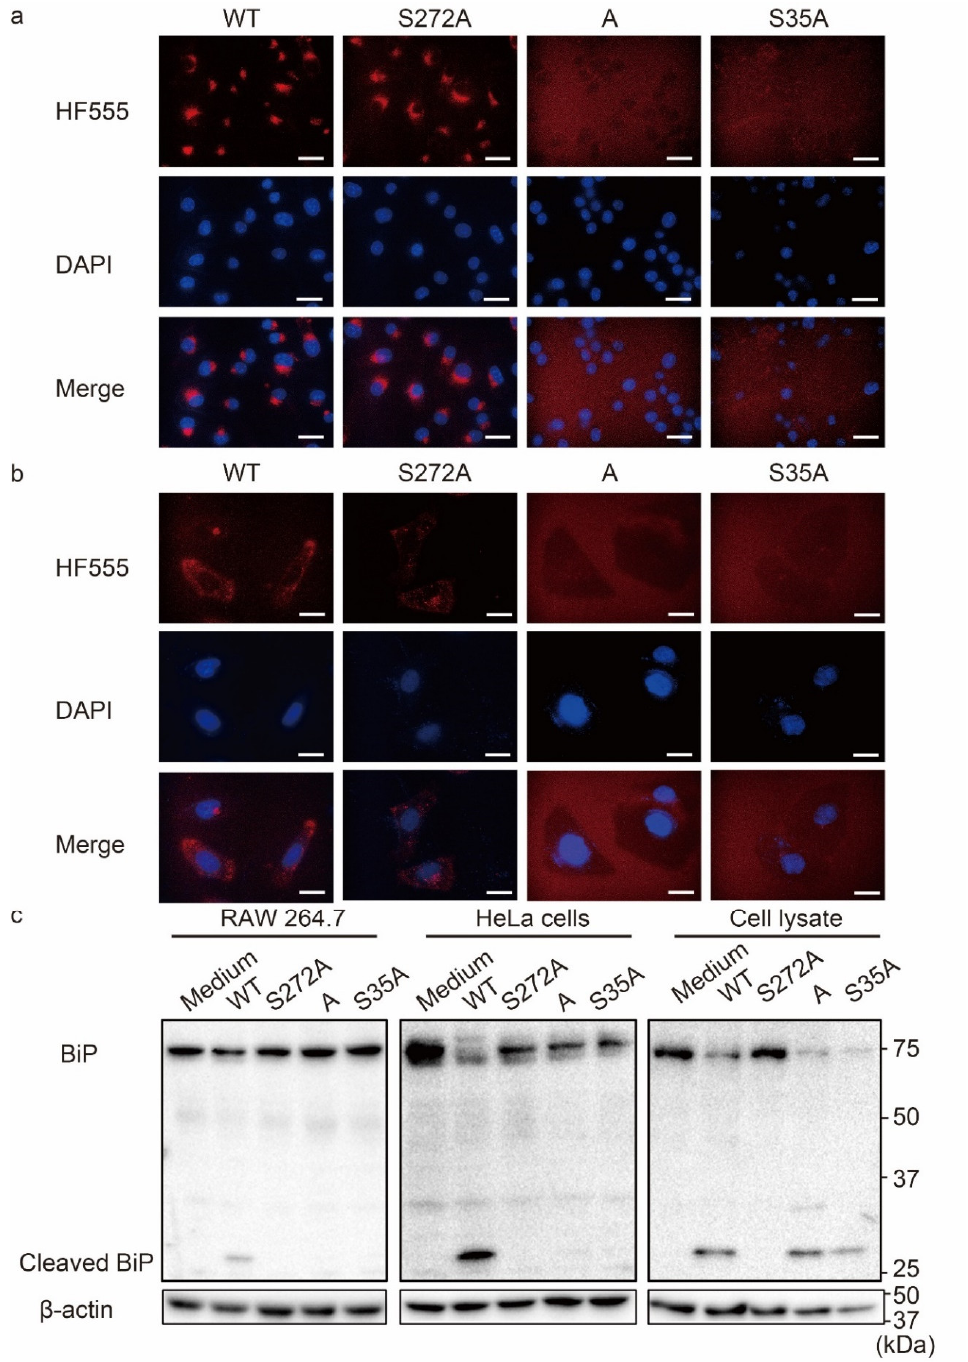
Figure 1. Evaluation of cellular uptake and BiP cleavage activity of various SubAB toxins. ( a , b ) RAW264.7 cells ( a ) and HeLa cells ( b ) were treated with 5 μg/mL Hylite555 (HF555)-labeled toxins and then incubated for 1 h at 37 °C. After adding a DAPI solution, cells were observed by fluorescence microscopy. WT: HF555-labeled wildtype SubAB; S272A: HF555-labeled SubA S272A B; A: HF555-labeled SubA; S35A: HF555-labeled SubAB S35A . Scale bars: 10 μm. ( c ) RAW264.7 and HeLa cells and a HeLa cell lysate were treated for 1 h with 5 μg/mL toxins. BiP cleavage in cultured cells and the cell lysate were evaluated by Western blotting. WT: wildtype SubAB; S272A: SubA S272A B; A: SubA; S35A: SubAB S35A . β -Actin served as a loading